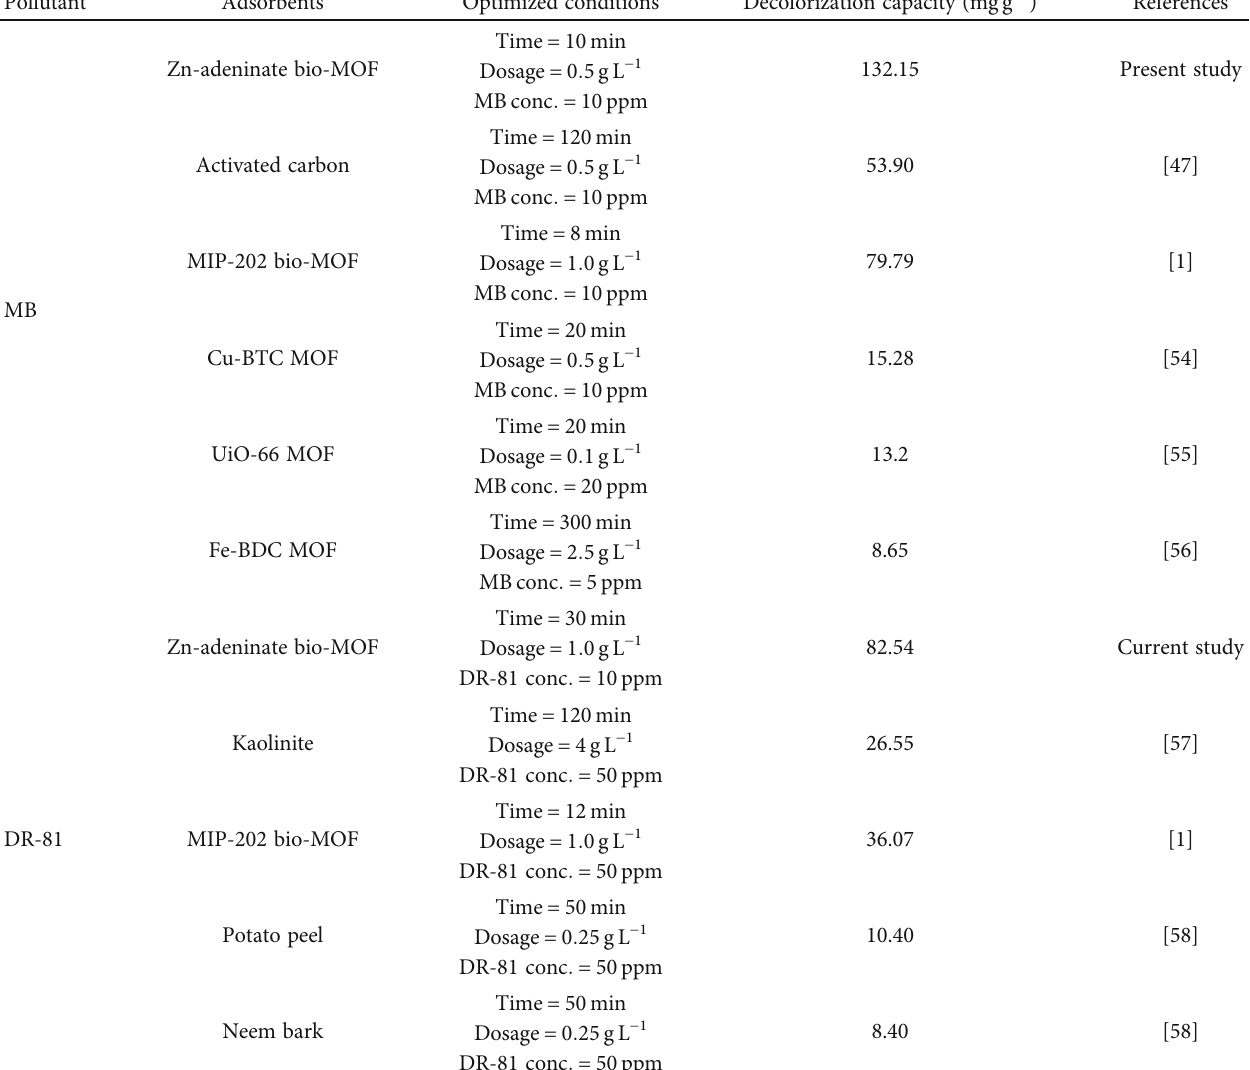
Table 3: Comparison of the monolayer decolorization capacities of MB and DR-81 for di ff erent nanoadsorbents.